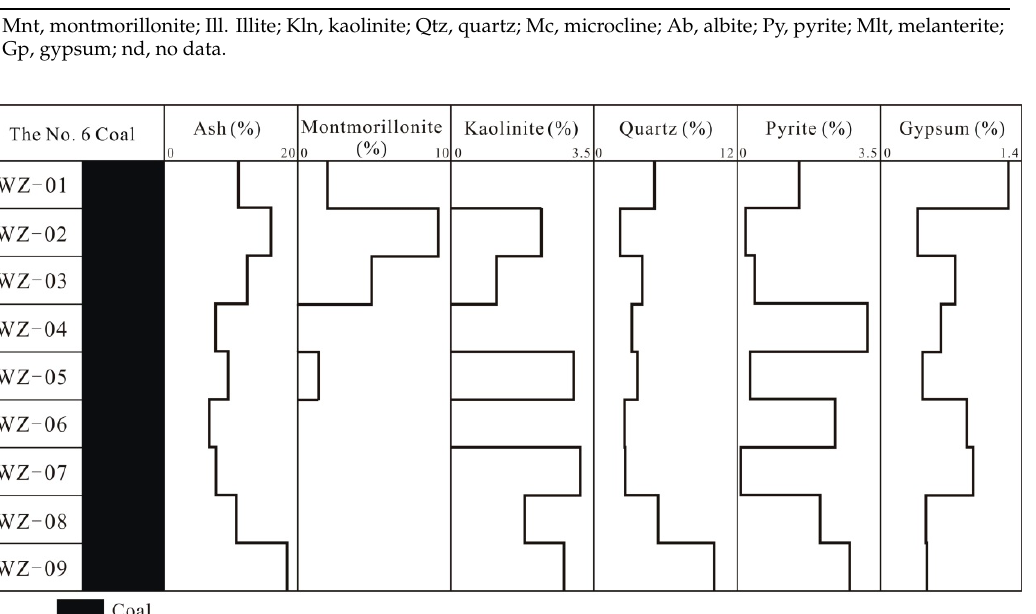
WLTG-01 T nd nd